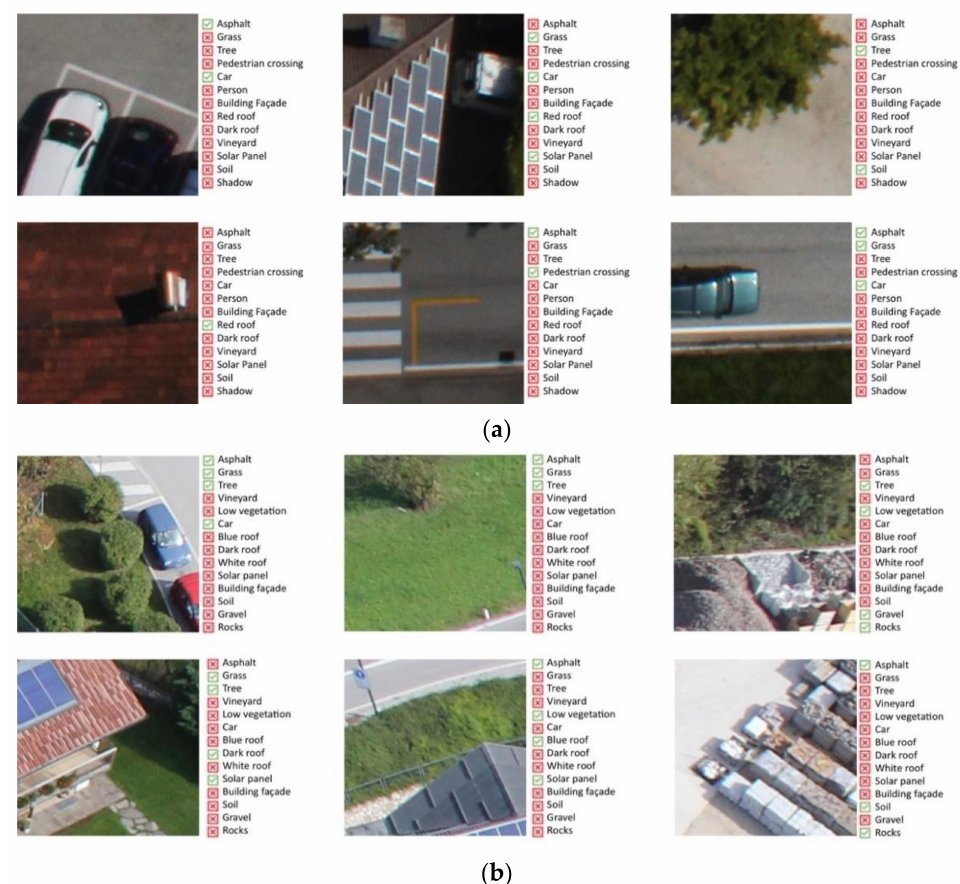
Figure 3. Sample images. ( a ) Trento and ( b ) Civezzano multi-label datasets (green color indicates the presence of the class while red color indicates the absence of the class in the image). Table 1. Information about multi-label UAV datasets. No. of No. of Classes